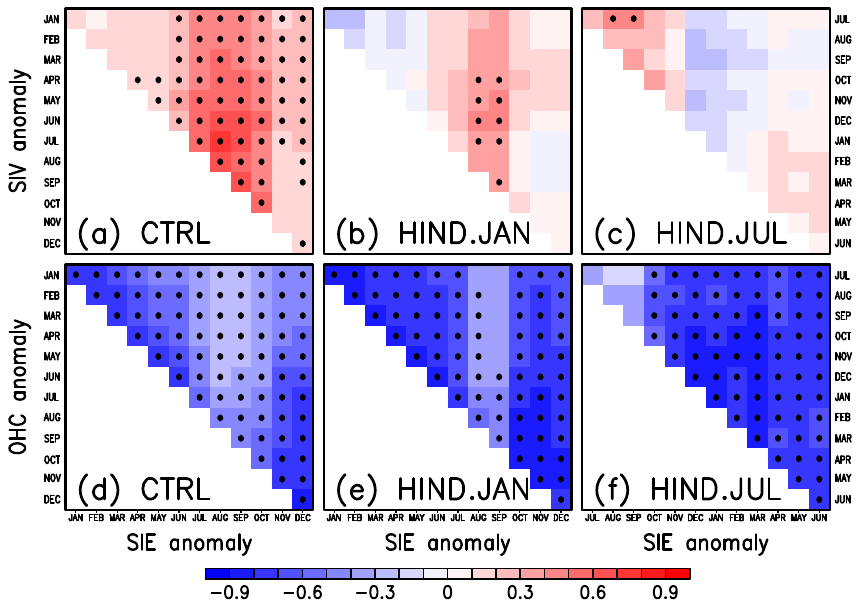
Figure 3. Lagged correlation coefficients between the detrended SIE AO anomaly, (a–c) the detrended SIV AO anomaly and (d–f) the de- trended OHC AO anomaly. Left, middle, and right panels indicate values obtained from the control run (CTRL), the hindcasts started from 1 January (HIND.JAN), and the hindcasts started from 1 July (HIND.JUL), respectively. Black dots indicate statistical significance at the 95% confidence level based on a two-sided Student’s t test with 30 and 200 degrees of freedom in the observations and model. Note that the horizontal and vertical axes in the hindcasts started from 1 July are different from those in the control run and the hindcasts started from 1